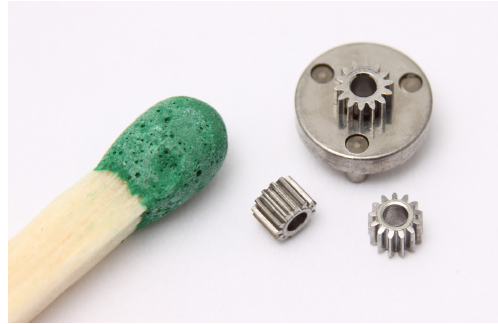
Figure 1. Gears of a micro-planetary drive. Diameter of the largest gear